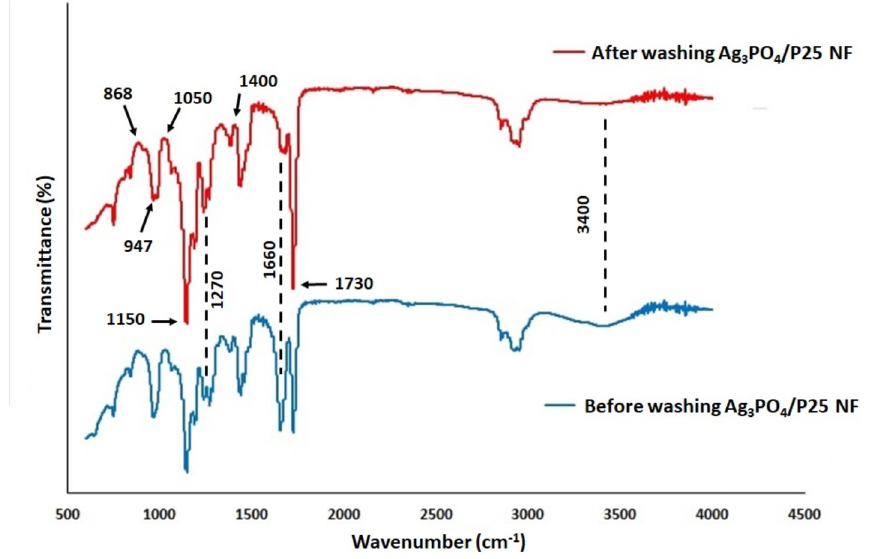
Figure 4. FTIR spectra of nanofibers before and after washing to remove PVP.